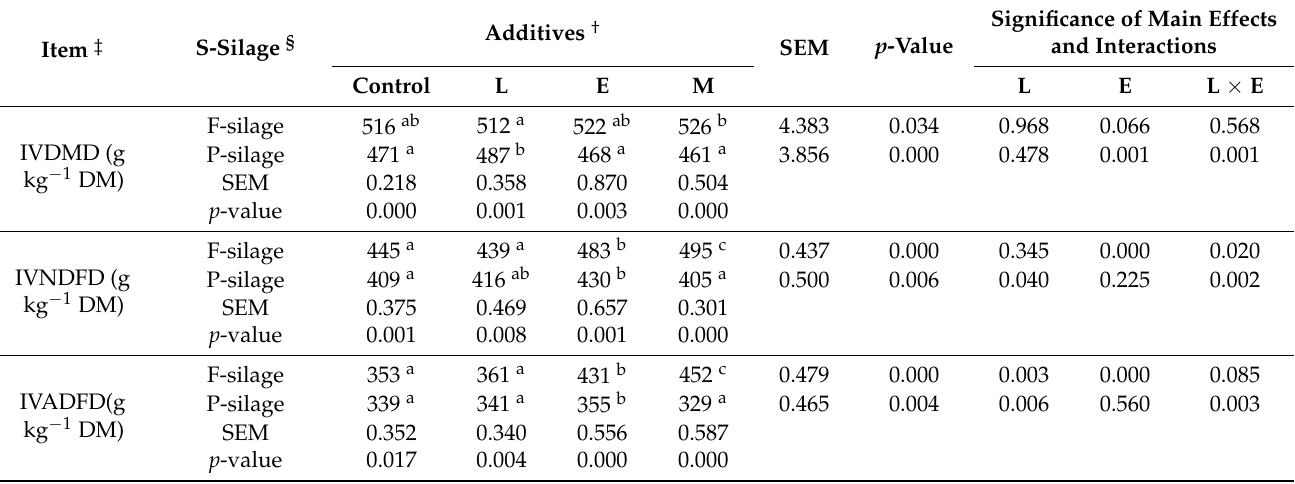
Table 6. In vitro digestibility of spent mushroom substrate silages prepared with lactic acid bacteria and